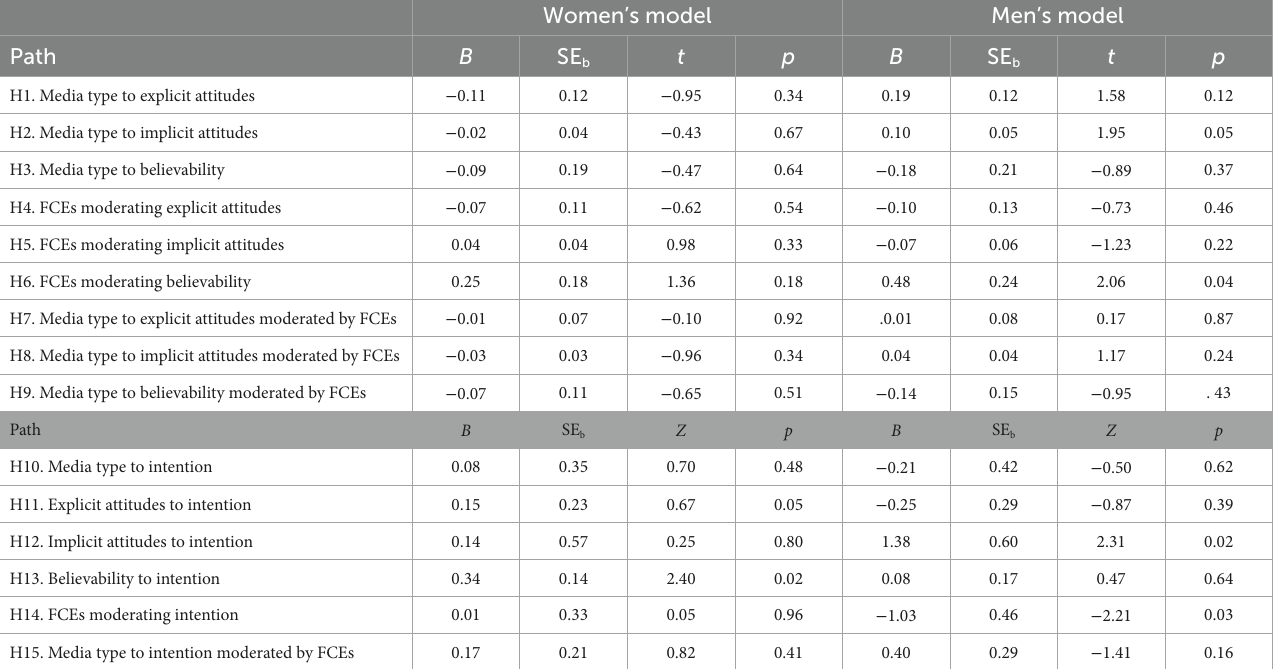
TABLE 6 Study two results with FCEs as moderator; women’s and men’s